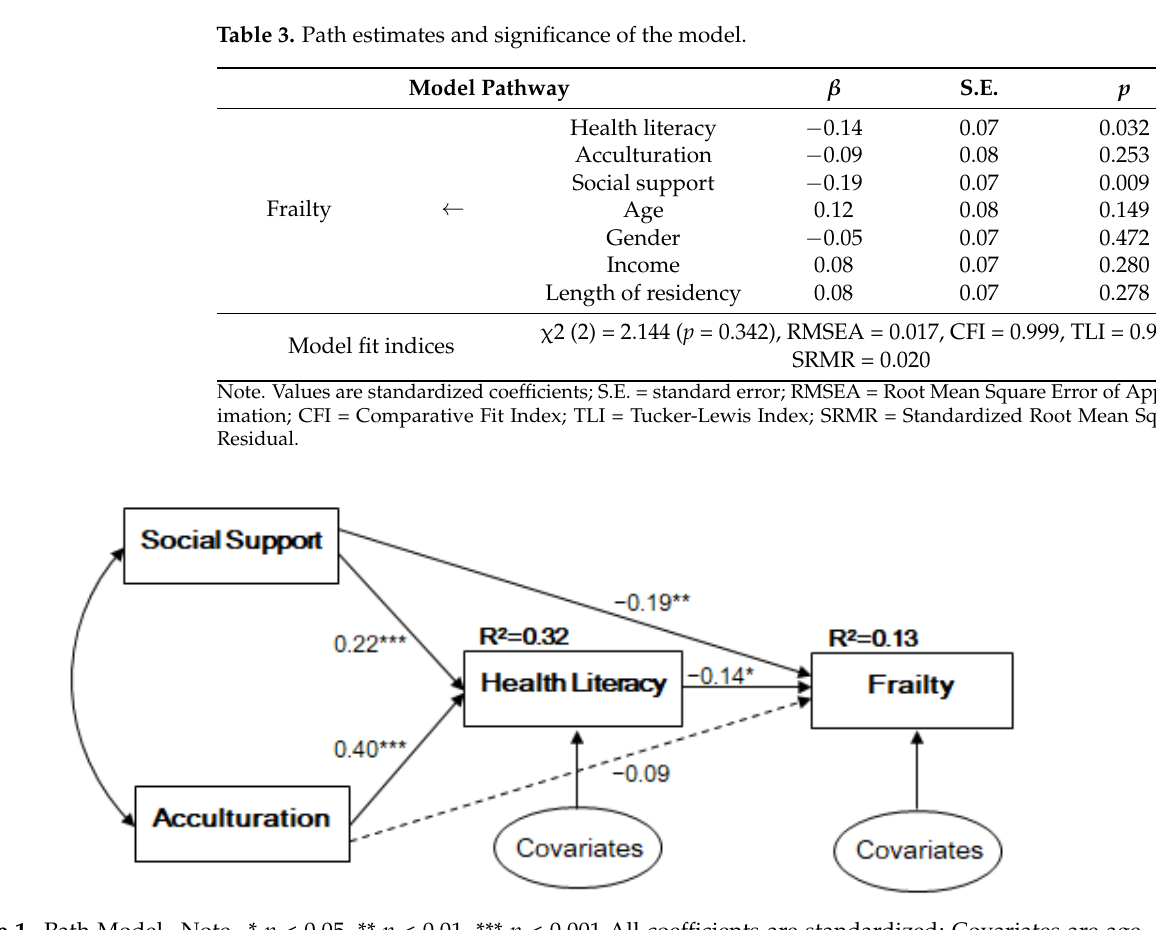
Figure 1. Path Model. Note. * p < 0.05, ** p < 0.01, *** p < 0.001 All coefficients are standardized; Covariates are age, gender, income, immigration period; Model fit indices: χ 2 (2) = 2.144 ( p = 0.342), RMSEA = 0.017, CFI = 0.999, TLI = 0.991, SRMR = 0.020.